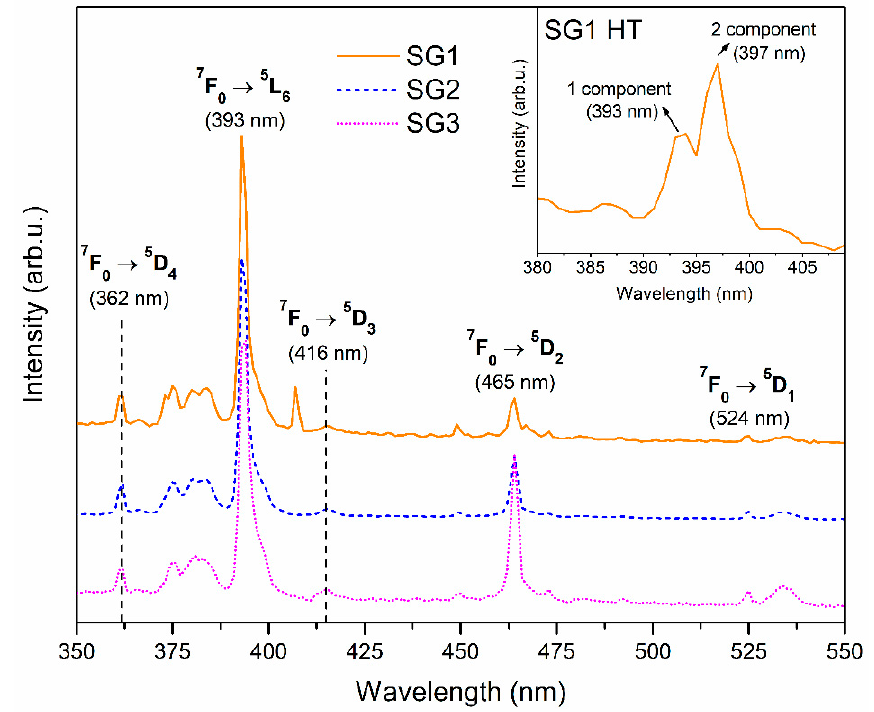
Figure 6. Photoluminescence excitation spectra (PLE) recorded for prepared xerogels monitored for red emission at 612 nm.